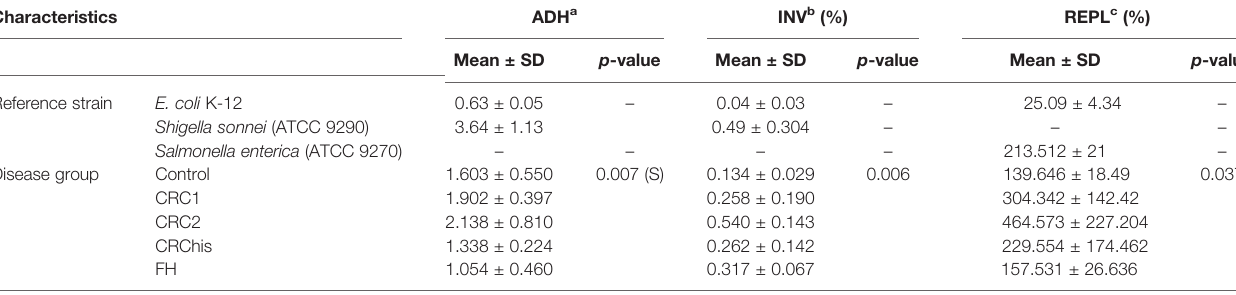
TABLE 3 | Characteristics of the isolated adherent – invasive Escherichia coli (AIEC) strains. Characteristics